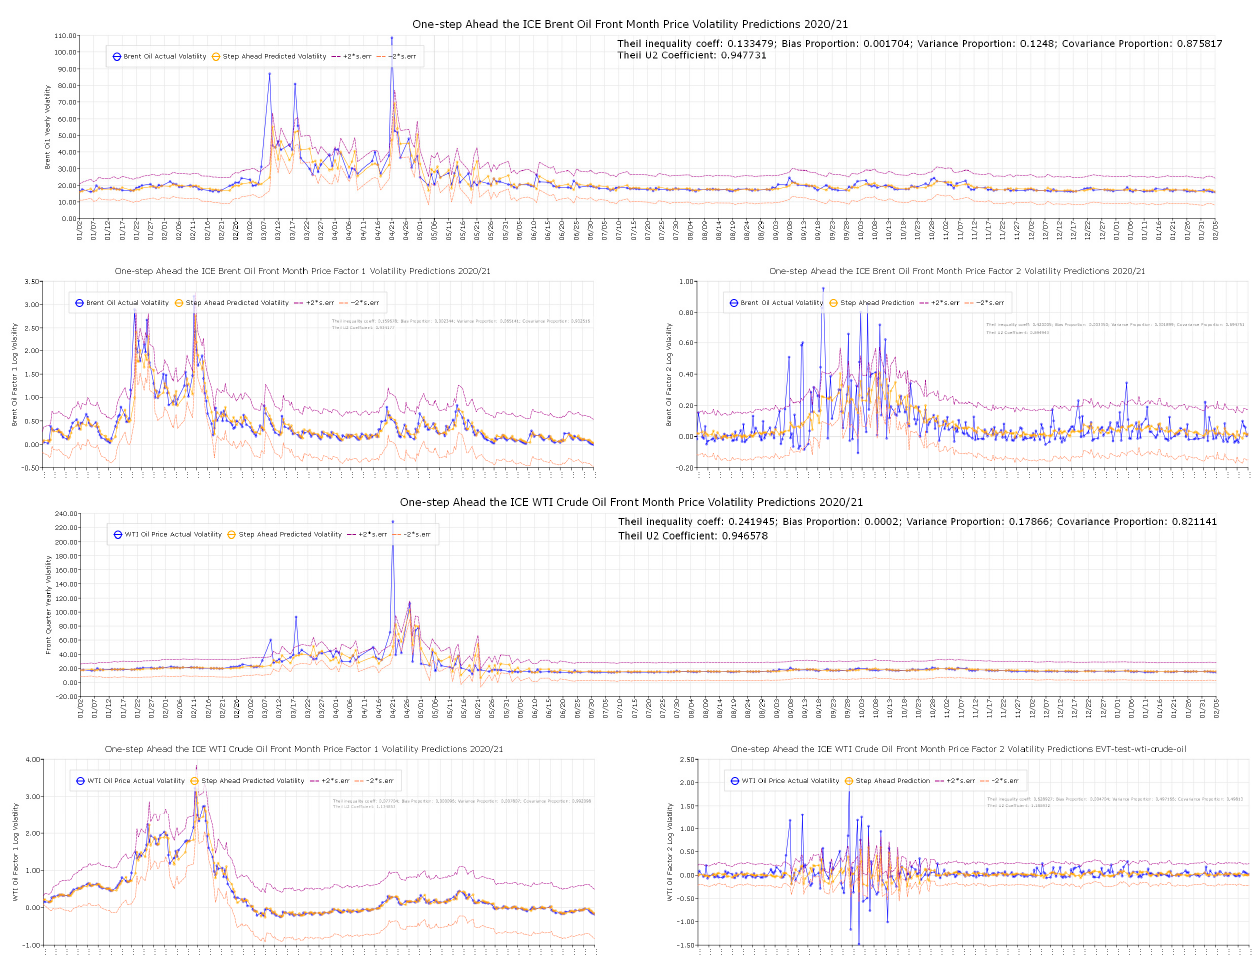
Figure 6. The ICE Brent Oil and WTI Crude Oil Front Month Contracts. Static Forecasts for 2020/21. Table 4. Estimated stochastic volatility model and static forecasts fit